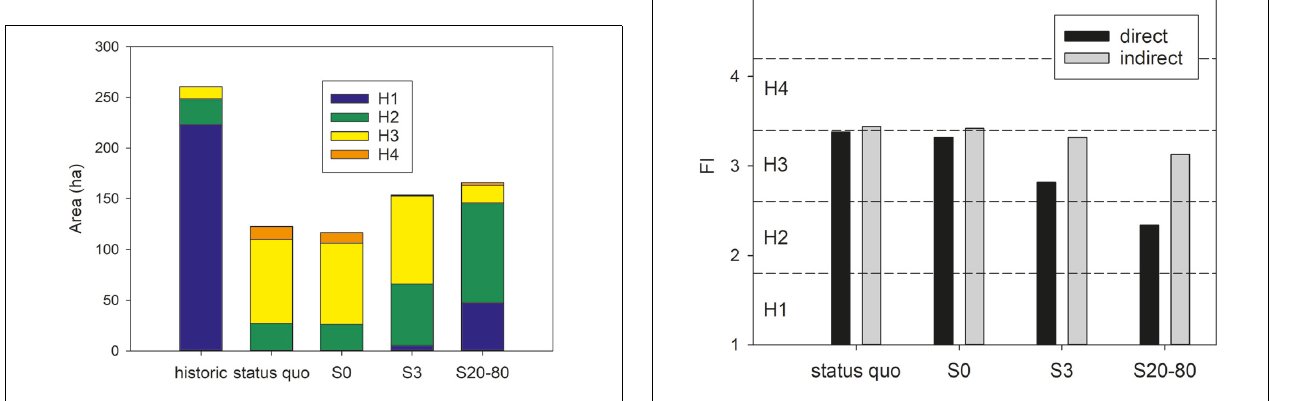
FIGURE 4 | Mean predicted value of the FI (habitat types H1-H5 according to Chovanec et al., 2005 are marked in the graph) in water bodies directly impacted by the respective restoration measure via surface discharge (direct) and indirectly due to increase in groundwater levels (indirect).